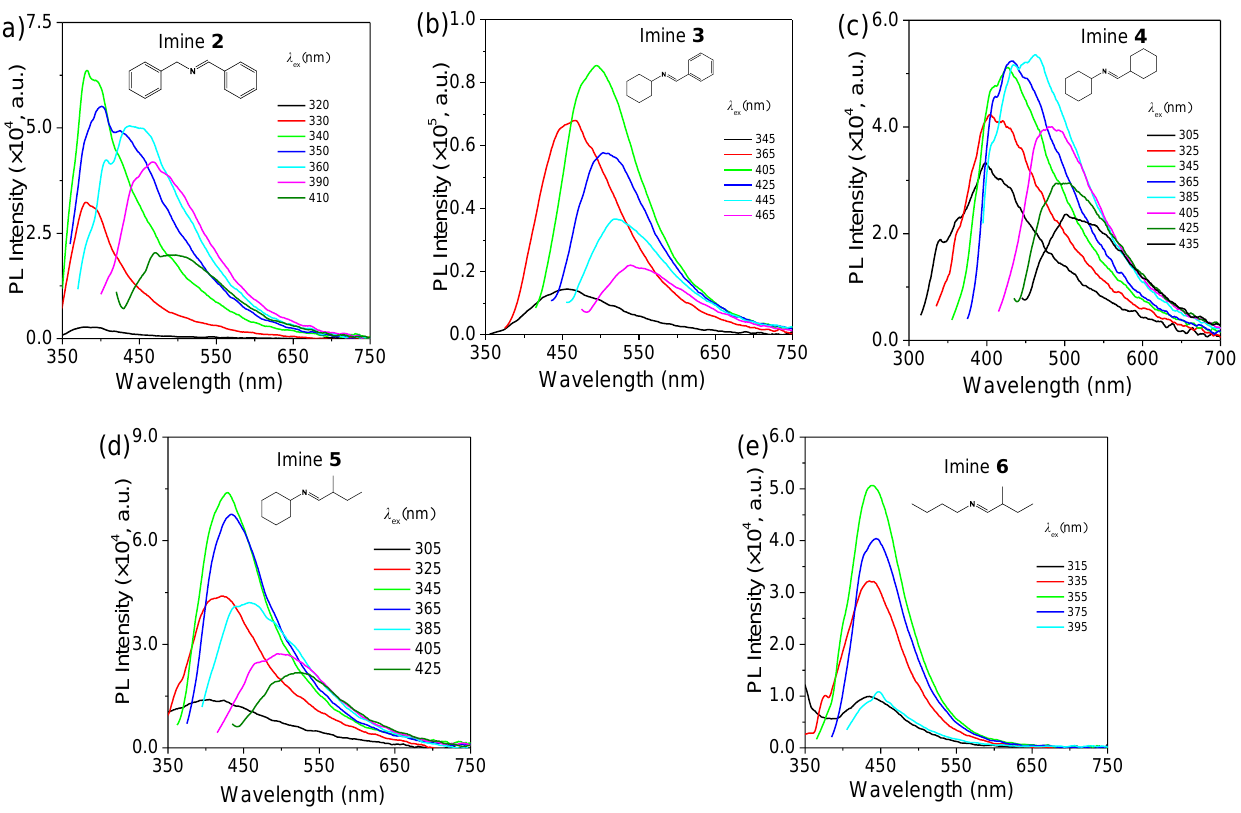
Figure 4. Fluorescence emission spectra of imines 2 – 6 ethanol solutions (5 vol.%) at different excitation wavelengths. (a-e): imines 2-6 , respectively.